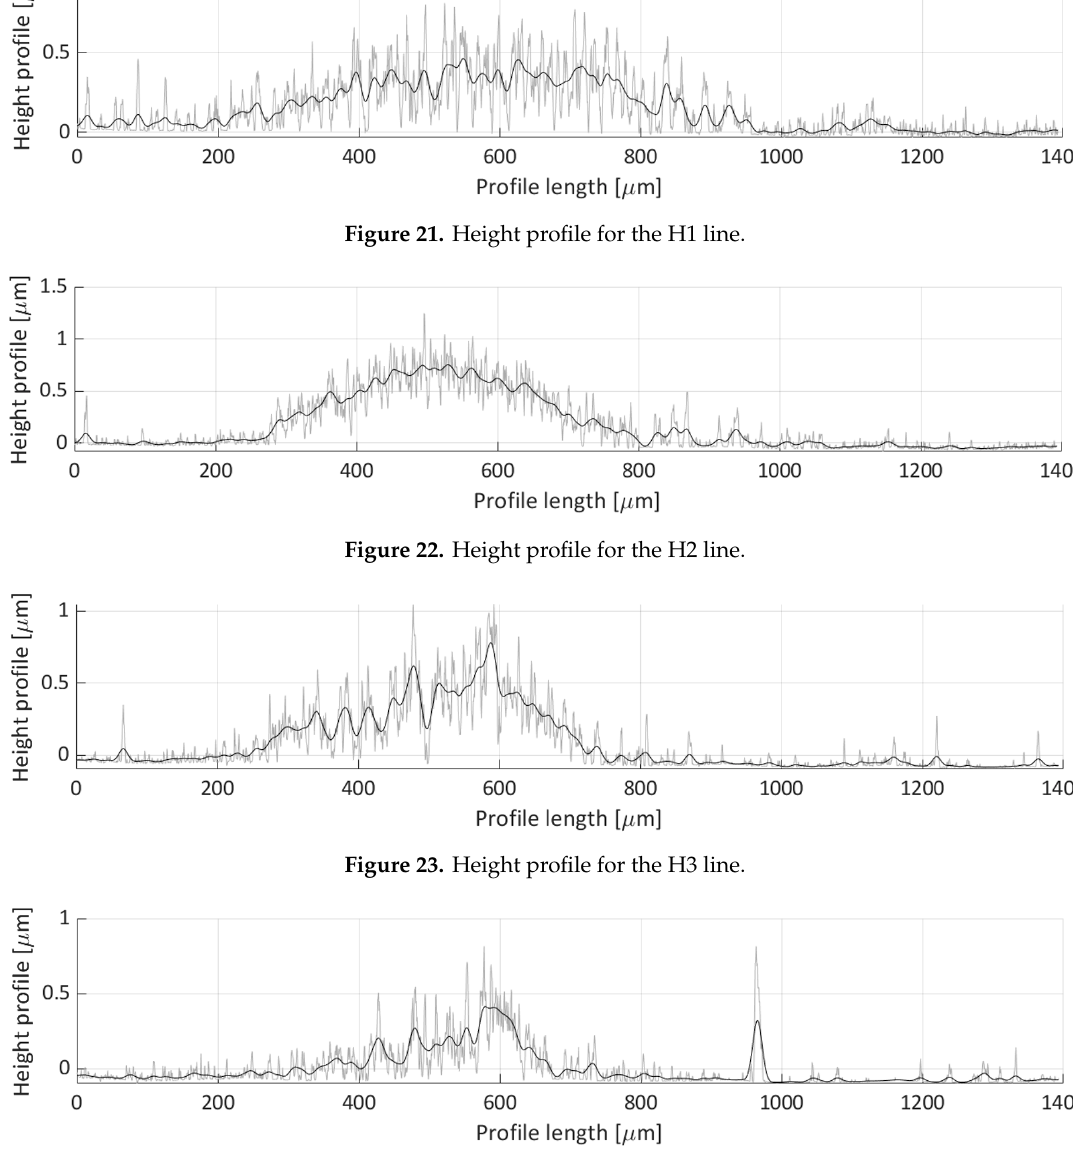
Figure 24. Height profile for the H4 line.